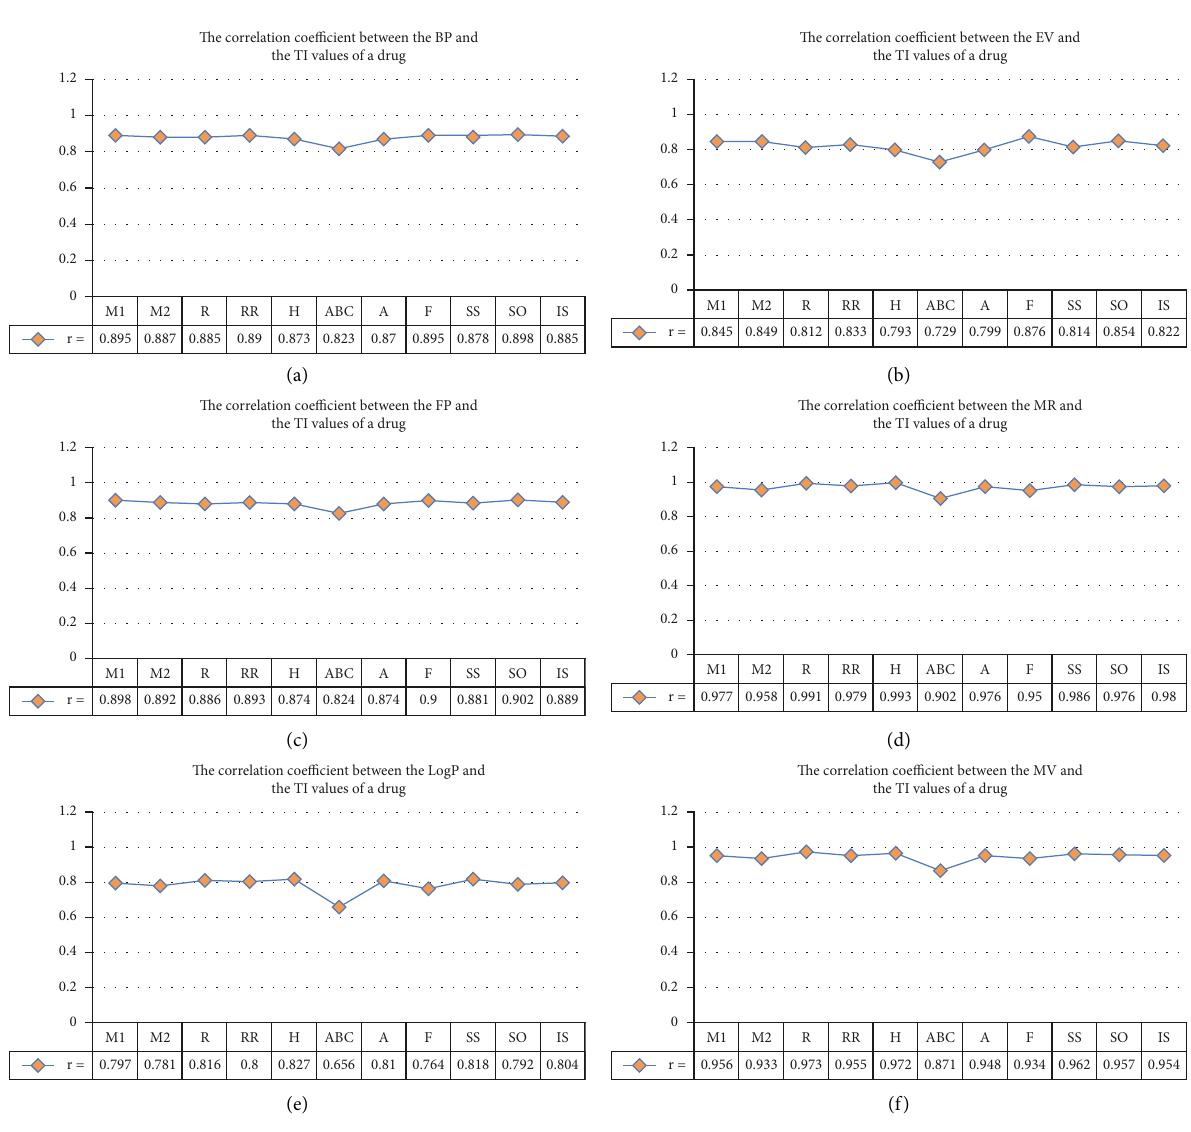
Figure 2: Topological indices and physicochemical properties of breast cancer